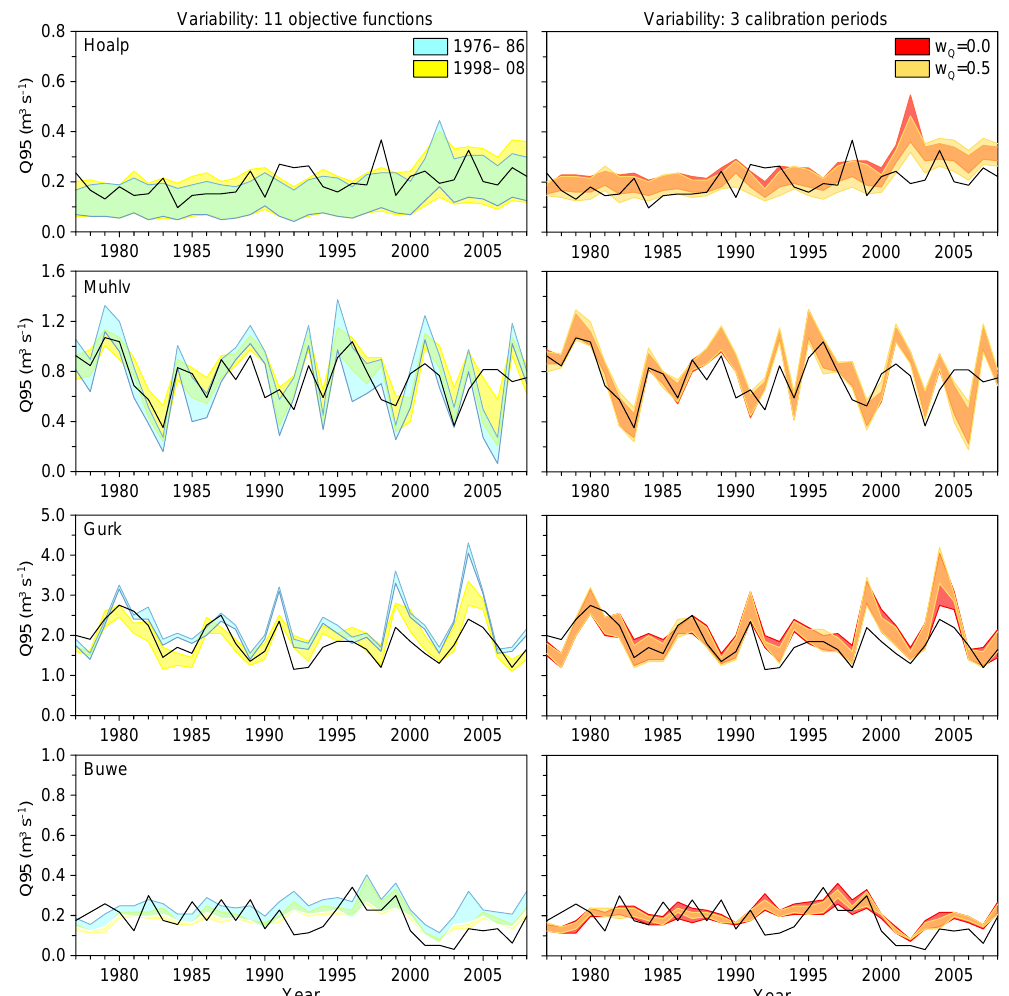
Figure 4. Annual Q 95 low flows from observed data (black lines) and from hydrologic model simulations (coloured bands) for the four catchments. Band widths in the left panels show the variability due to different weights w Q in the objective function (Table 3) for two calibration periods (1976–1986 and 1998–2008). Band widths in the right panels show the variability due to different decades used for model calibration for two sets of weights ( w Q = 0.5 and w Q =